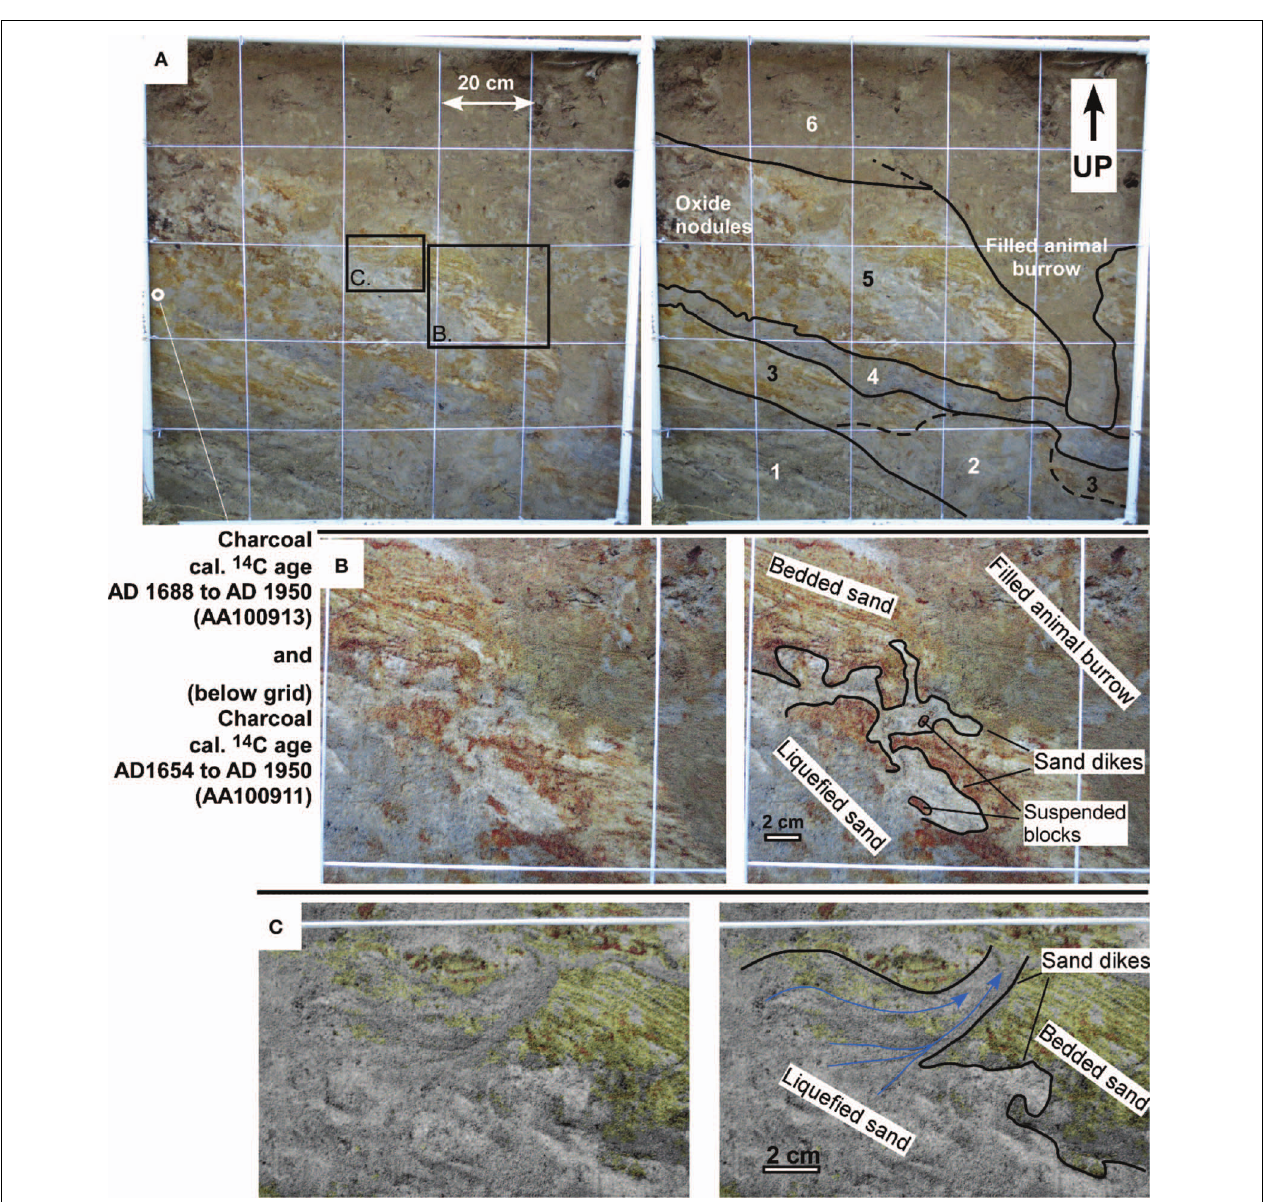
FIGURE 4 | Site B (Hungerrun Creek; 33.69237 ◦ N, 91.87181 ◦ W)—Top is up. Locations of (B,C) are shown on (A) . (A) Uninterpreted (left) and interpreted (right) photograph of 1 × 1m grid of vertical excavation showing small-scale bedding irregularities interpreted to be caused by ground shaking and liquefaction. Unit 1, Hungerrun Creek channel, medium-bedded coarse sand and gravel; Unit 2, Structureless (liquefied?) fine/medium sand; Unit 3, Hungerrun Creek point-bar, medium-bedded fine sands; Unit 4, Hungerrun Creek point-bar, massive clay-rich fine sand; Unit 5, Convoluted Hungerrun